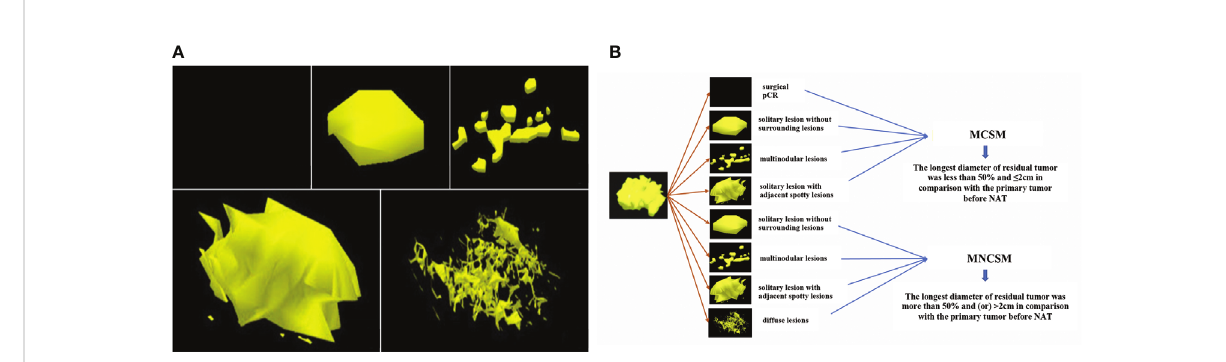
FIGURE 3 The shrinkage modes of residual tumors after NAT. (A) : The traditional shrinkage classi fi cation modes, including surgical pCR, solitary lesion without surrounding lesions, multinodular lesions, solitary lesion with adjacent spotty lesions and diffuse lesions. (B) : The modi fi ed shrinkage classi fi cation modes, including MCSM and